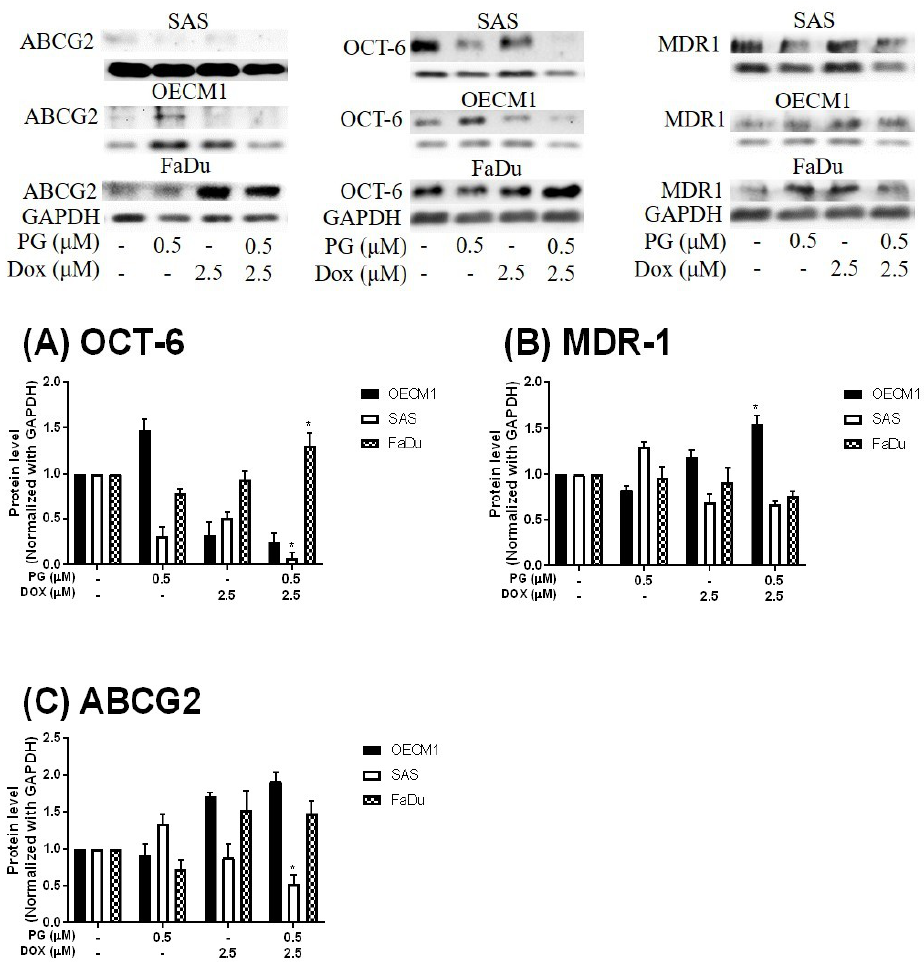
Figure 6. Protein levels of Doxorubicin-related importer and exporter after PG-priming. OSCC cells were treated with PG/Dox for 12/12 h and then were analyzed for Importer OCT-6 ( A ) and exporter MDR-1 ( B ) and ABCG2 ( C ) protein levels by Western blotting. The results were normalized with GAPDH and represented as mean ± SD from three individual experiments. Molecular weight: MDR-1, 170 KDa; ABCG2, 72 KDa; OCT-6, 58 KDa; GAPDH, 37 KDa. * p < 0.05 compared with Dox